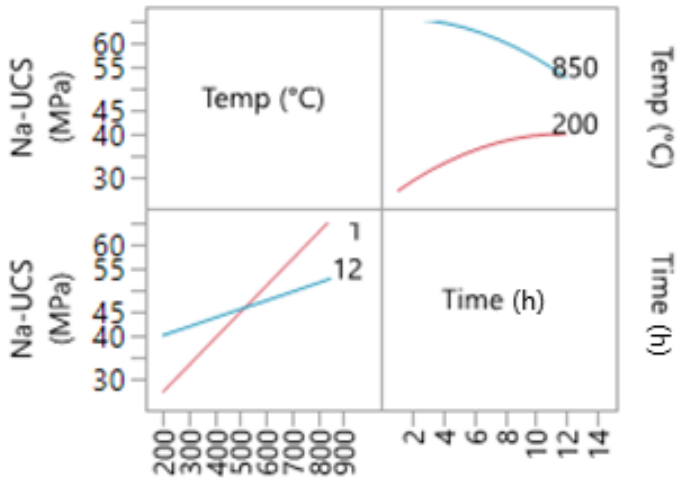
Materials 2021 , 14 , x FOR PEER REVIEW Figure 6. Interaction profile for time and temperature (Na-based liquid). Figure 6. Interaction profile for time and temperature (Na-based liquid).